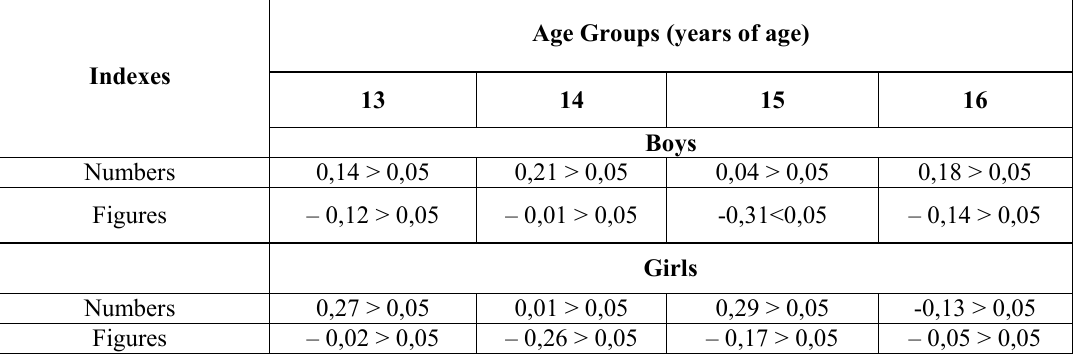
Correlation Indexes of Physical Development Coefficient with Amount of Short-Term Visual Memory for Numbers and